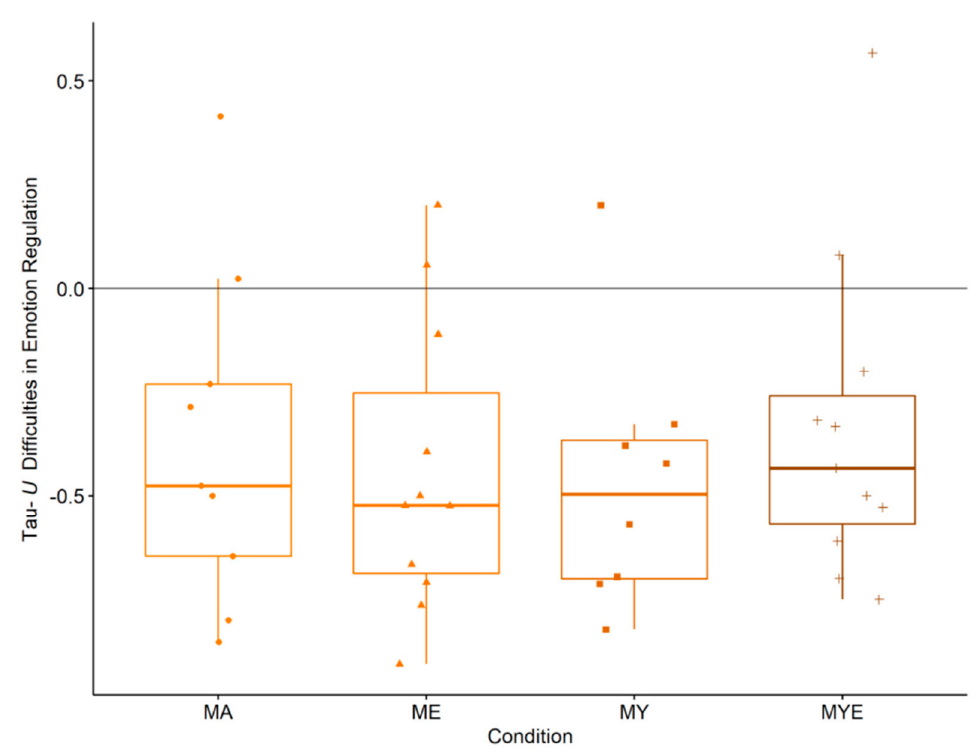
Figure 4. Box plots for averaged Tau- U difficulties in emotion regulation effect size estimates in each condition. Individual estimates are scattered across the box plots. Note . MA = Mantra meditation only (dots); ME = meditation and ethical education (triangles); MY = meditation and physical yoga (squares); MYE = meditation, physical yoga, and ethical education (pluses). Whiskers represent the largest and lowest values within a distance of 1.5 times the interquartile range.